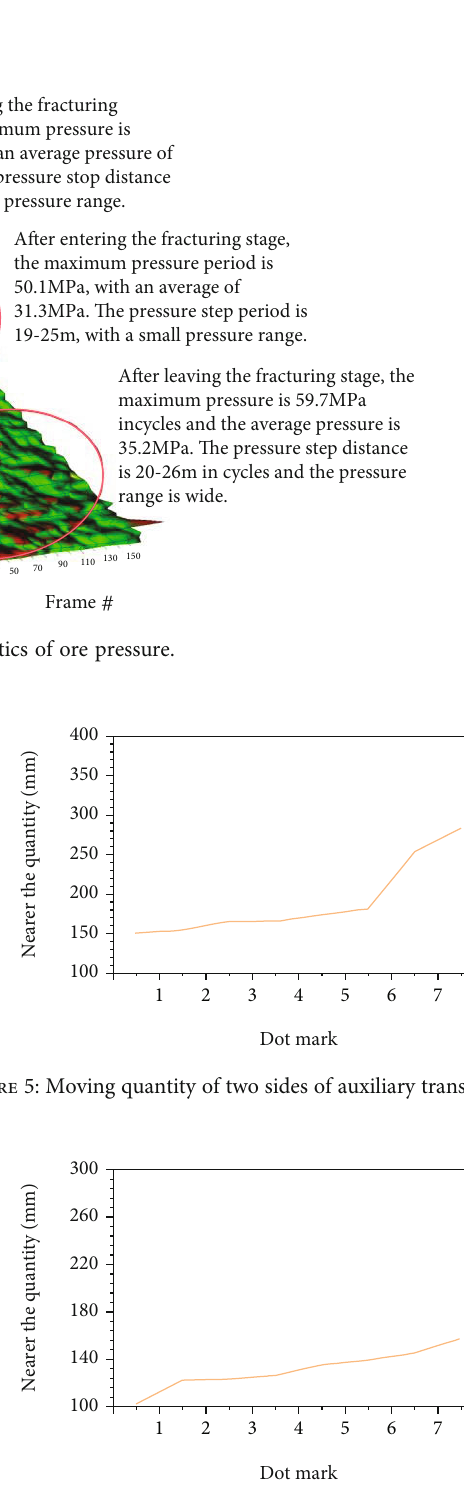
Figure 6: Top and bottom plate displacements of auxiliary